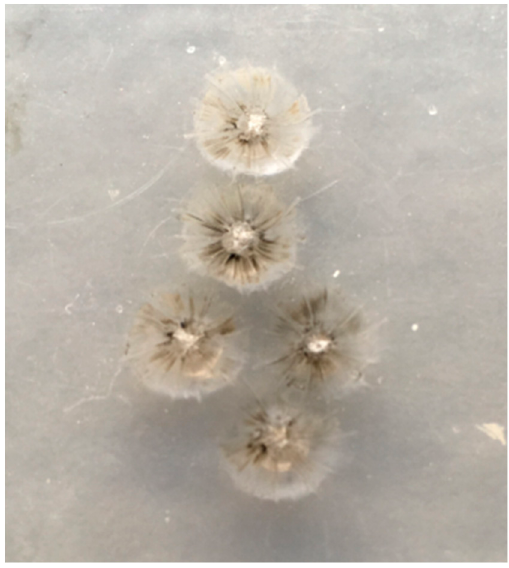
Figure 11. Multiple-shots at different locations.